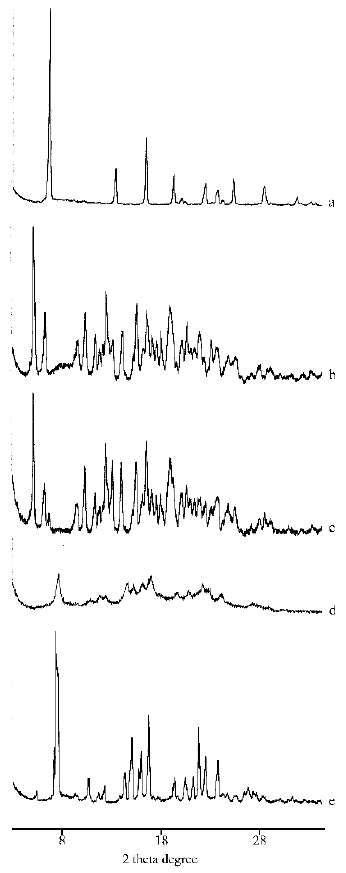
Figure 10. PXRD patterns of RSV ( a ), γ-CD ( b ), their PM ( c ), KN( d ), and the CCP ( e ) products.